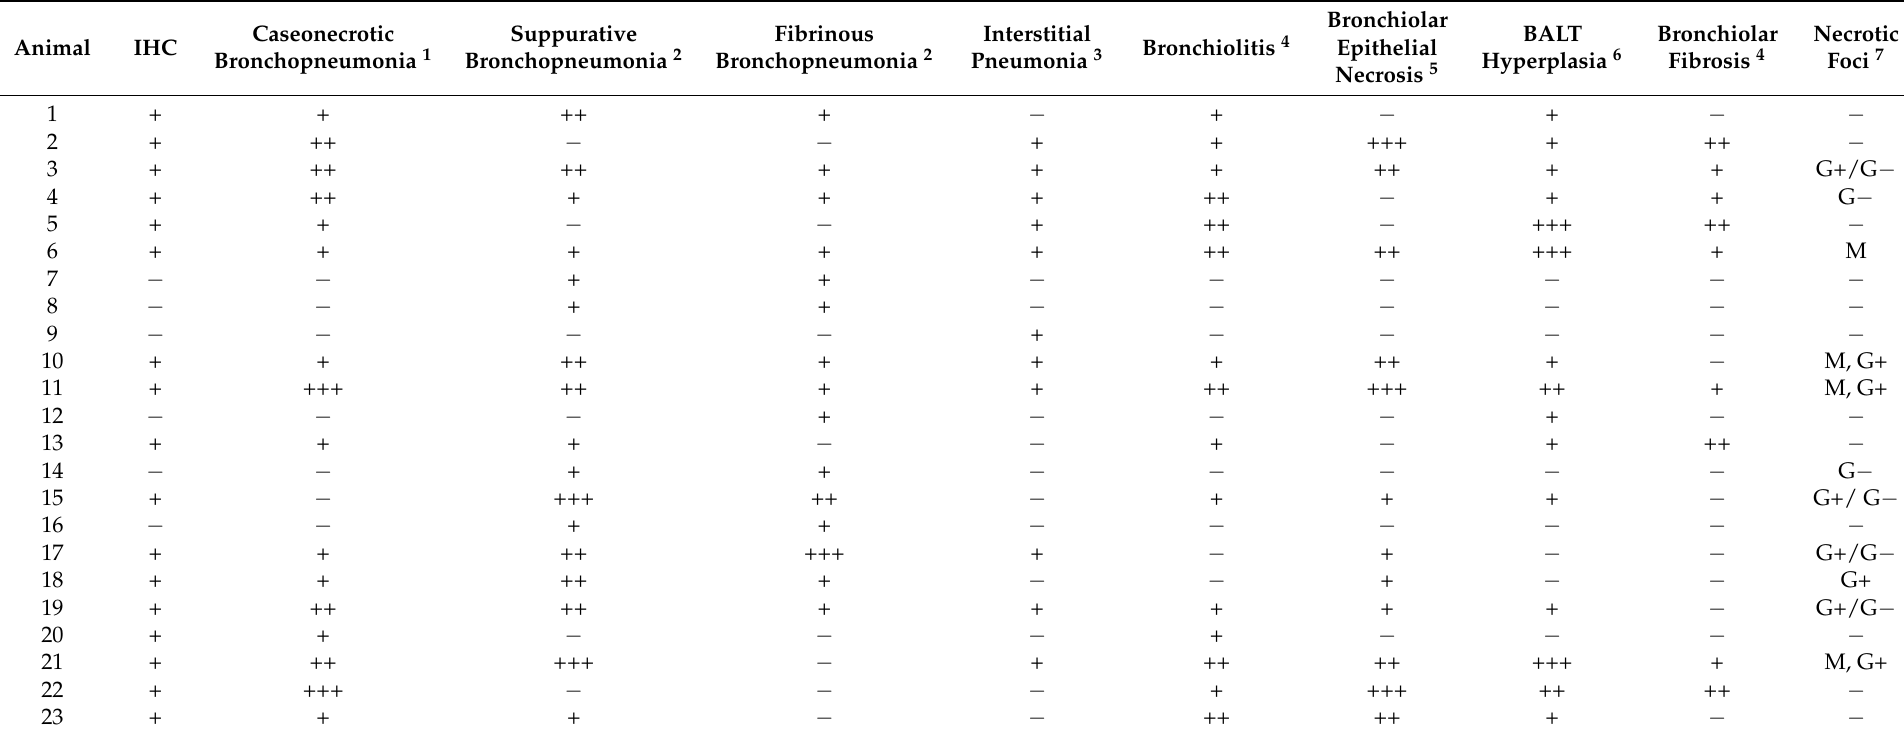
Table 2. Histopathological lung lesions and detection of Mycoplasma bovis by immunohistochemistry